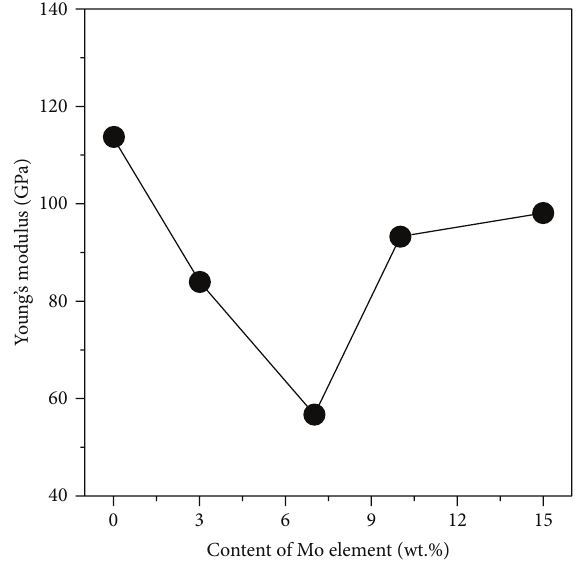
Figure 3: XRD patterns of the Ti-xMo alloys. Table 2: Corrosion potentials ( 𝐸 ), and passivation current densities ( 𝐼 ( 𝐼 corr polarization